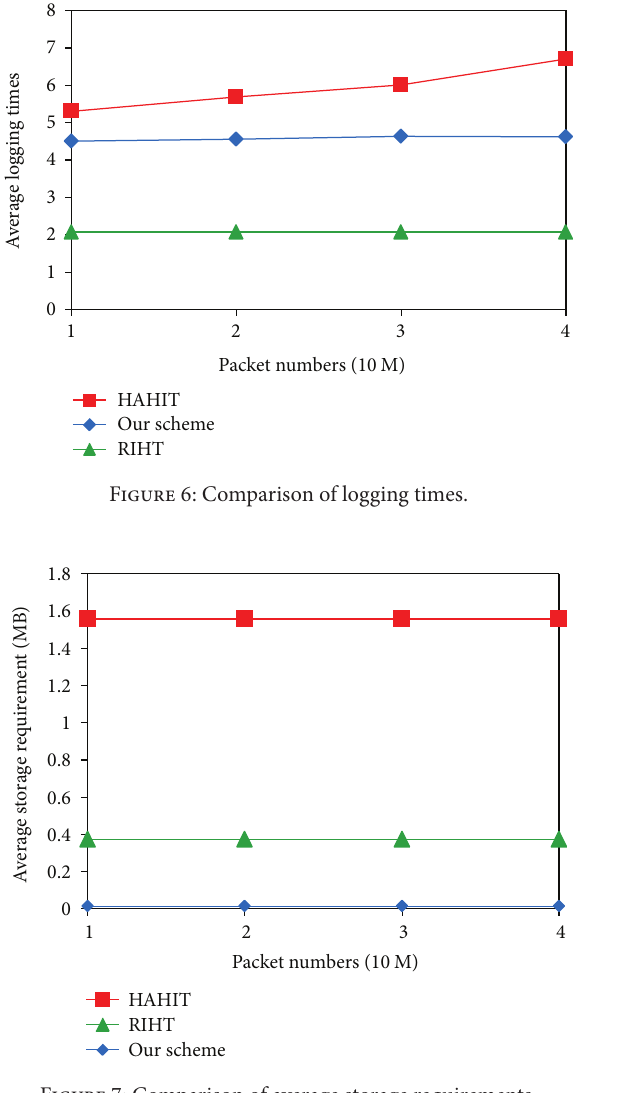
Figure 7: Comparison of average storage requirements.